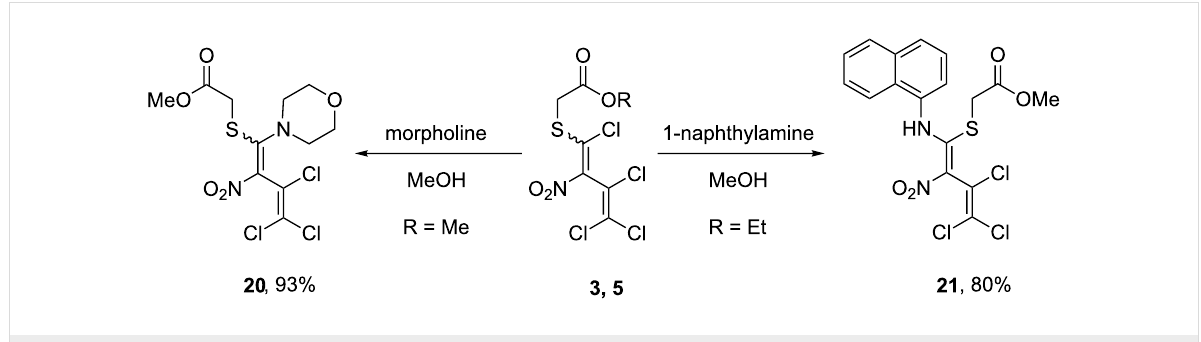
Scheme 4: Substitution reactions of the precursors 3 and 5 with additional amines.